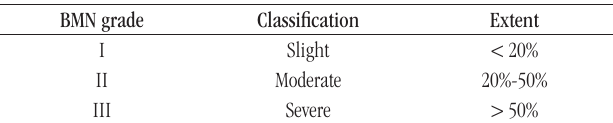
taBLE 3 − Classification of BMN according to the extent of BM involvement in a biopsy